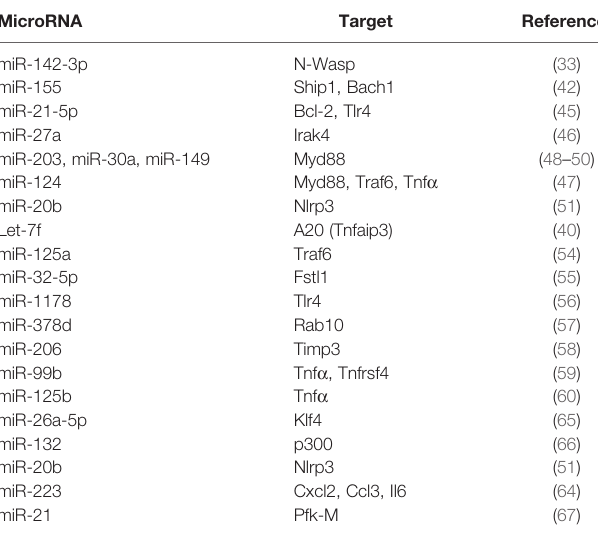
TABLE 1 | MicroRNAs that target signaling in myeloid cells during M. tuberculosis infection to regulate phagocytosis, cytokines, chemokines, macrophage polarization and